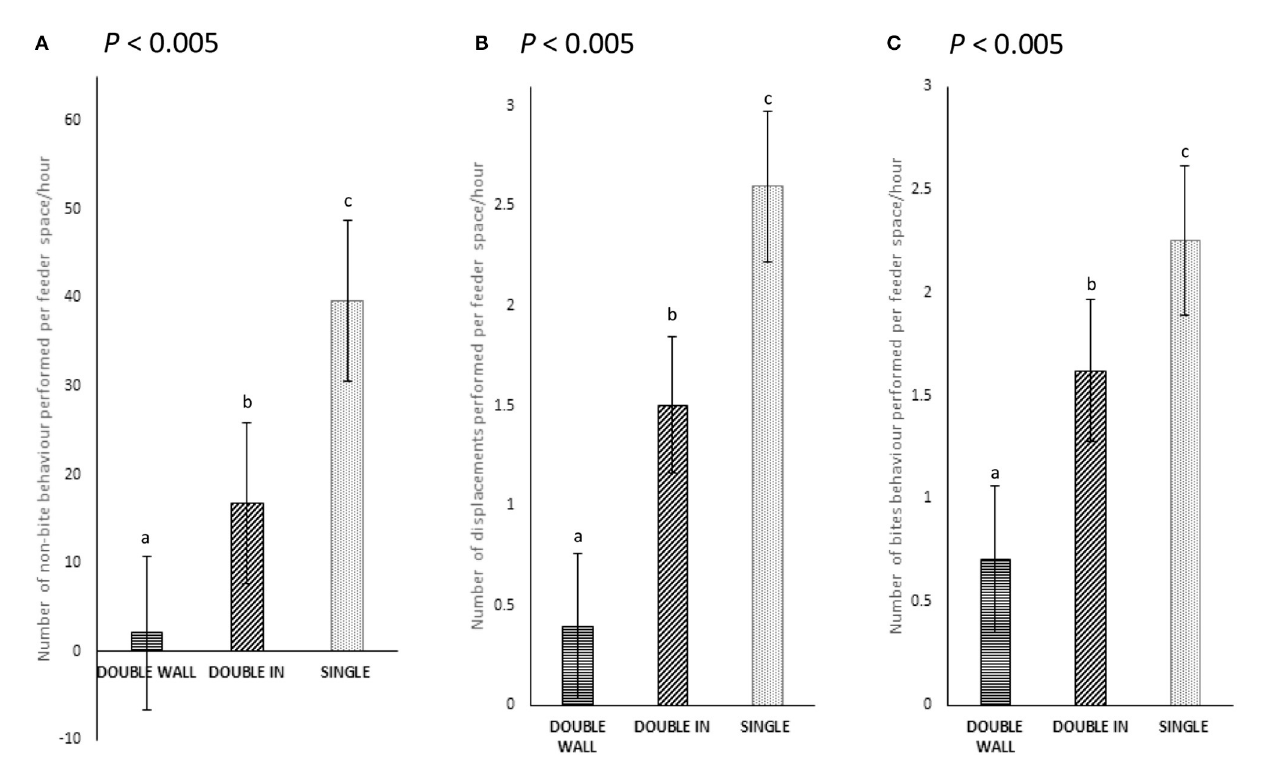
FIGURE6 (A–C) The number of non-biting, biting, and displacements behaviors performed at feeder space (instances/min) in both SINGLE and DOUBLE ( P < 0.005). The different letters represent significance